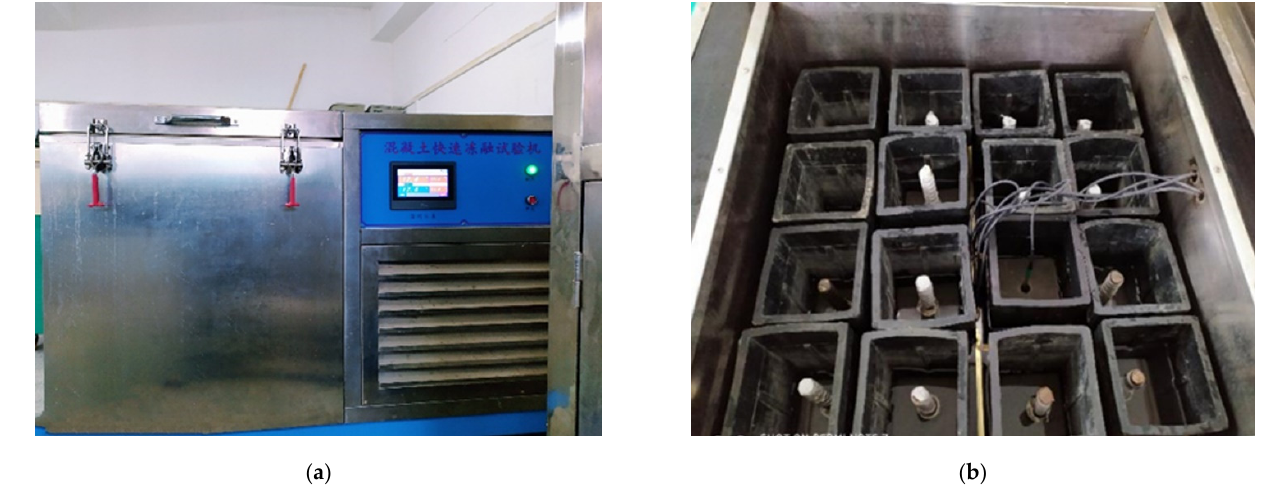
Figure 2. Freeze–thaw method: ( a ) Instrument; ( b ) Internal configuration.